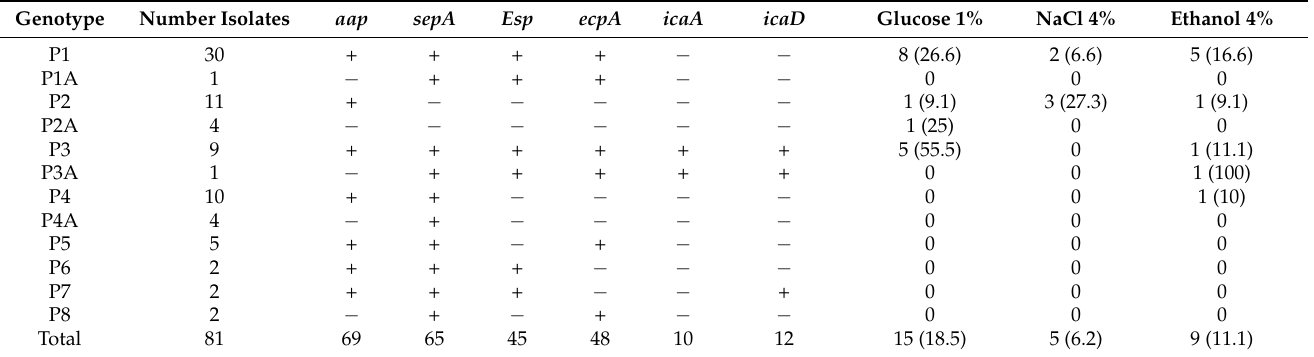
Table 1. Genotypic and phenotype characteristics in S. epidermidis with non-biofilm forming pheno-